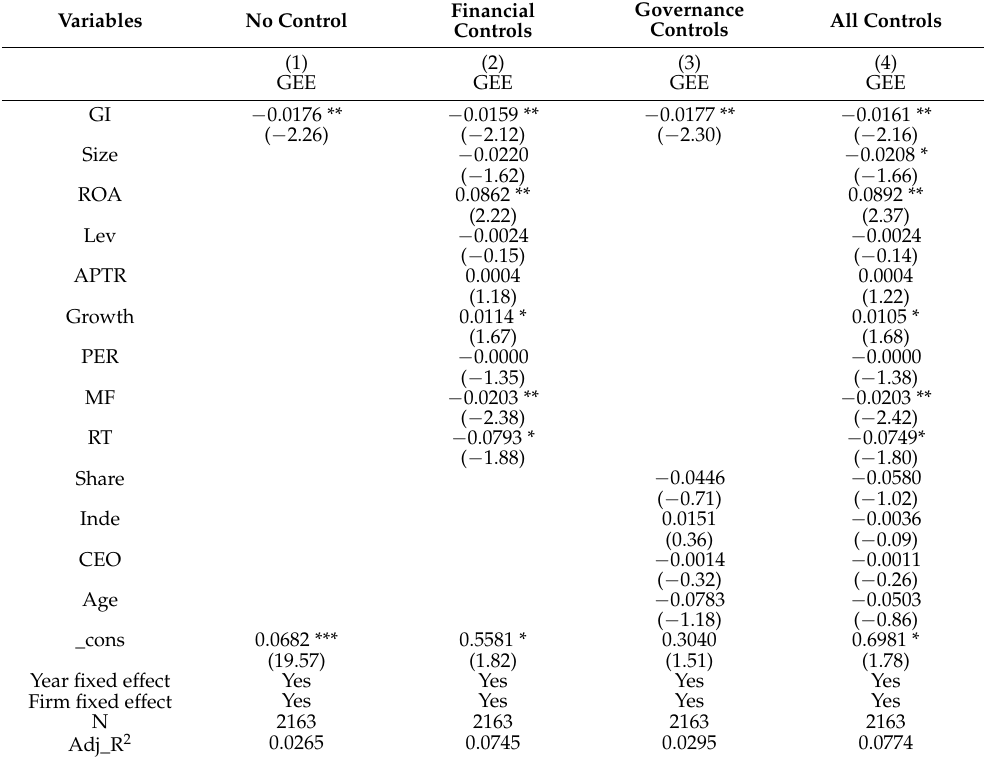
Table A3. Green innovation and green economic efficiency (Full version of Table